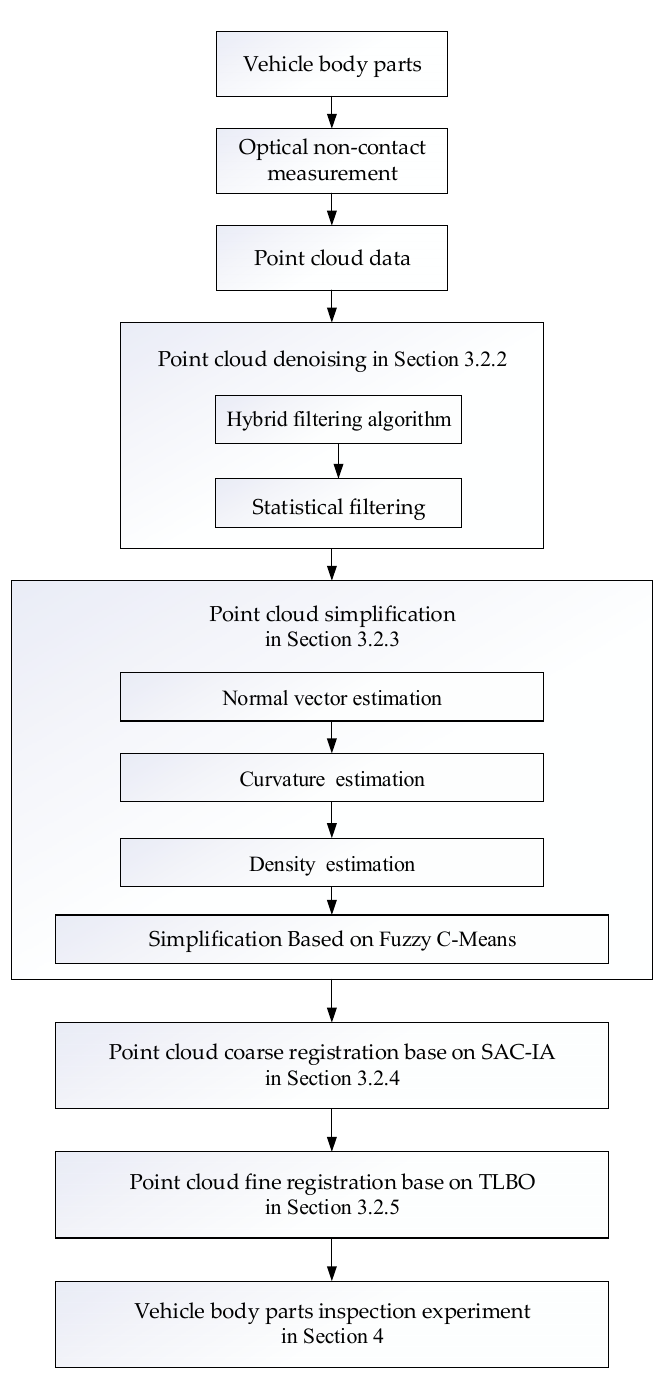
Figure 4. The scheme flow of inspection process.